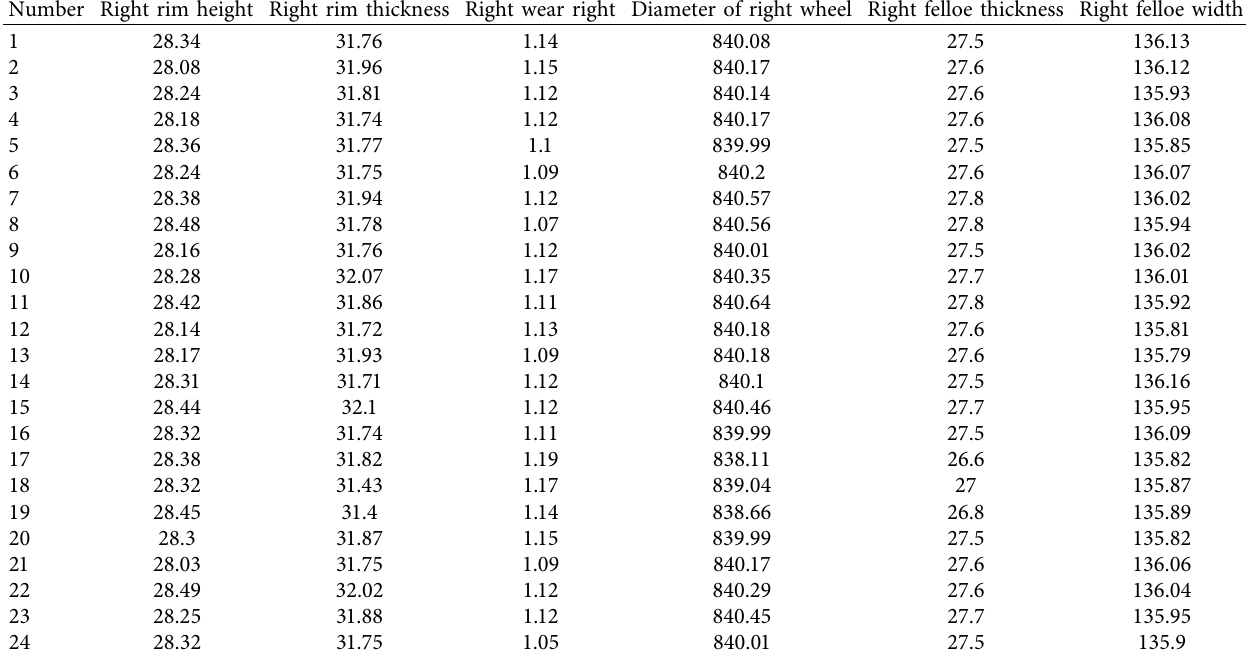
Figure 3: Part of images obtained based on CCD camera for first group of wheel set. Table 1: Main parameters of right